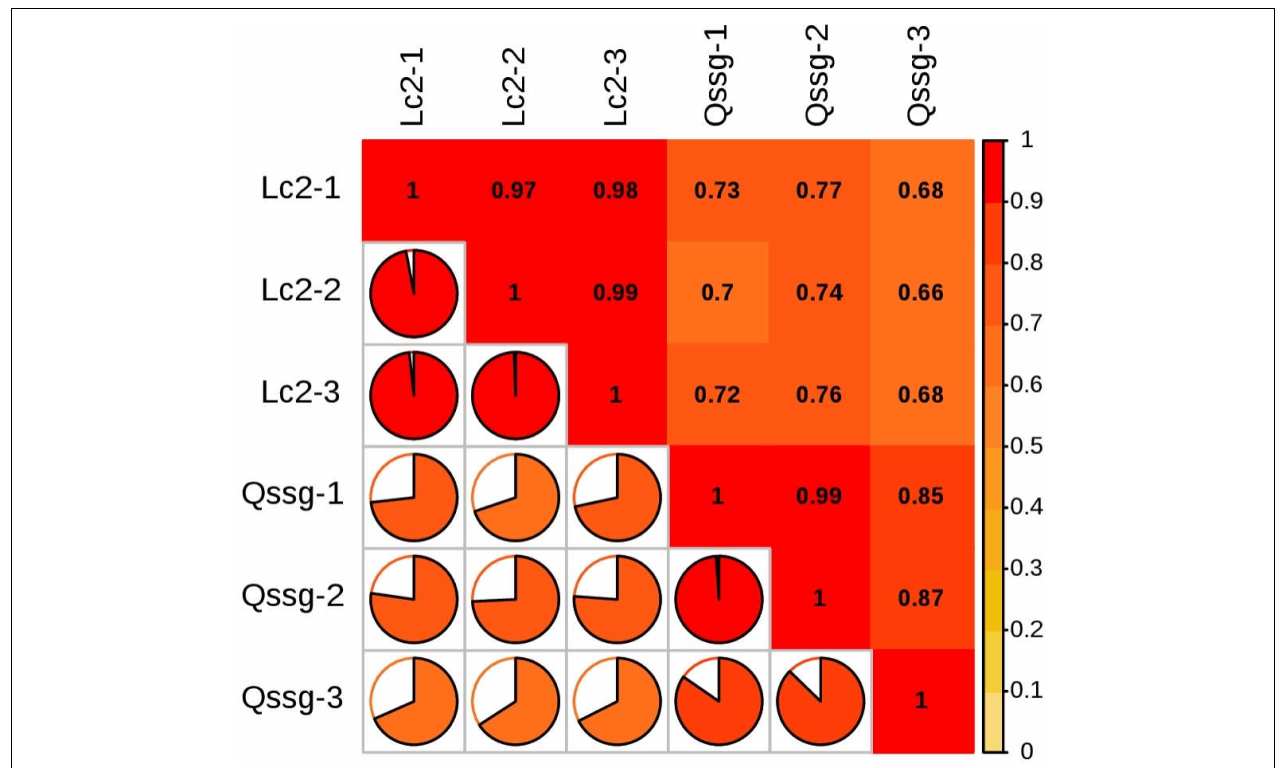
FIGURE 10 | Heat map of gene correlation coefficient of difference in Qssg and Lc